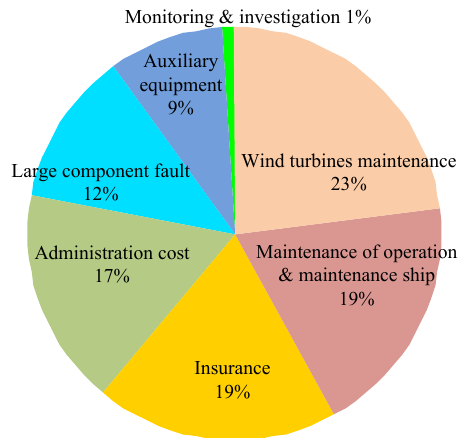
Figure 17. Operation and maintenance cost of offshore wind